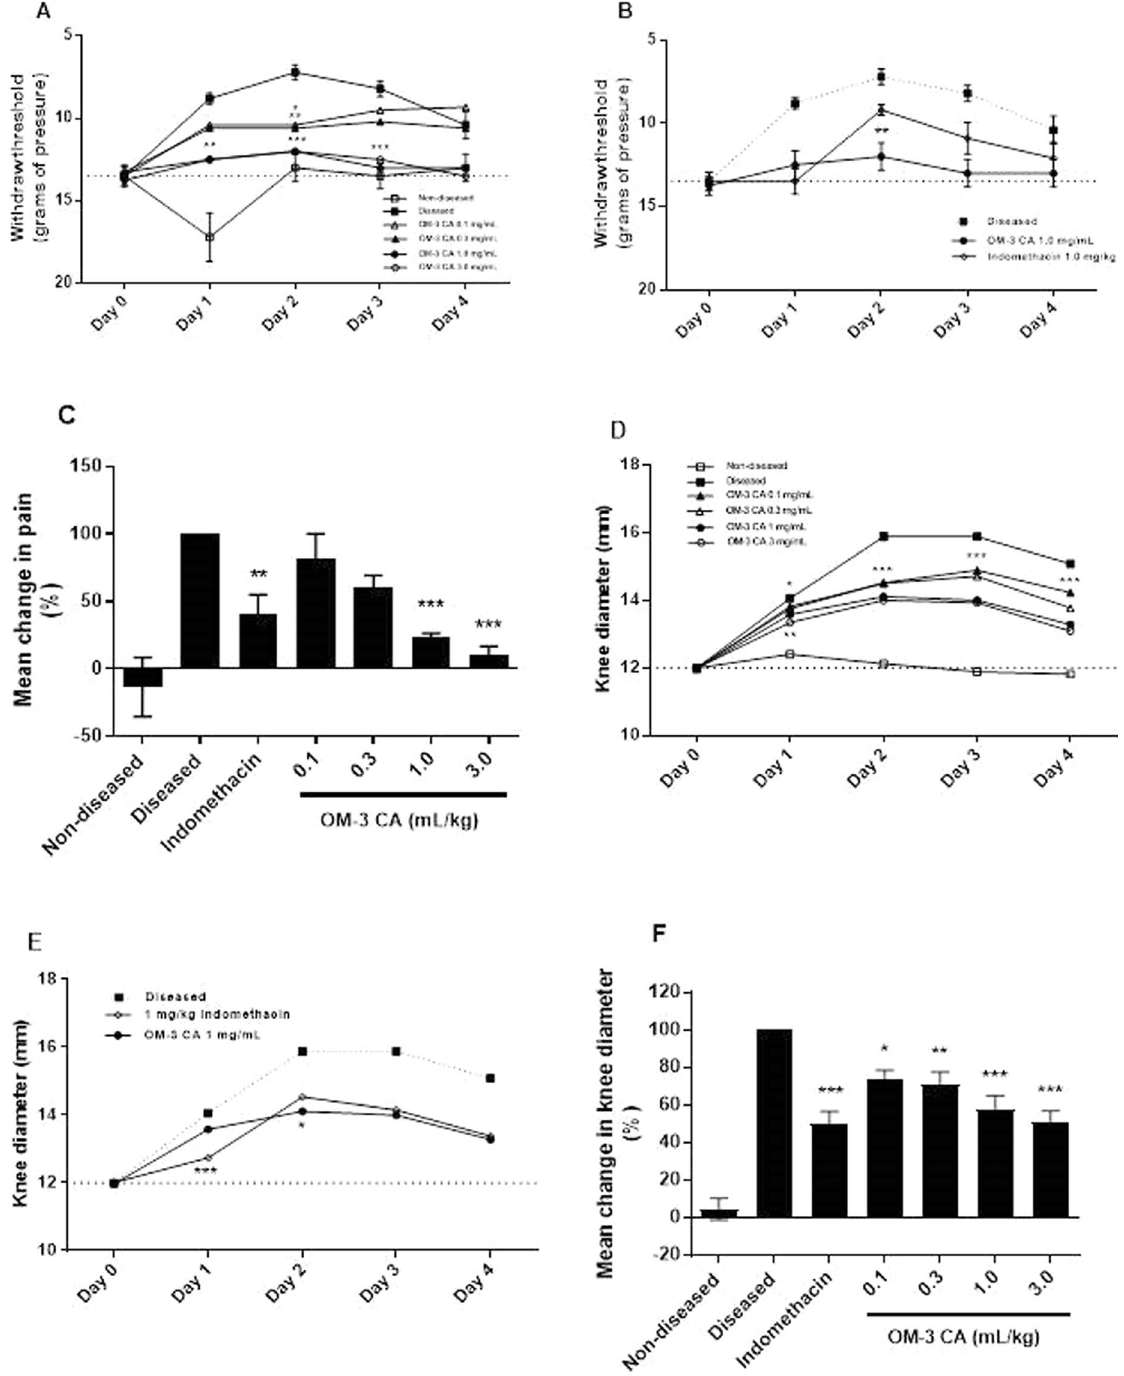
Figure 4. OM-3 CA efficacy in the rat intra-articular knee injection model. ( A ) Daily disease progression as measured by mean withdraw threshold (grams of pressure) over the 4-day study period for OM-3 CA treatment groups. ( B ) Daily disease progression as measured by mean withdraw threshold (grams of pressure) over the 4-day study period for OM-3 CA 1.0 mL/kg versus indomethacin 1.0 mg/kg daily. ( C ) Mean percentage change in pain level over the 4-day study period compared with the diseased group. ( D ) Daily disease progression as measured by knee diameter over the 4-day study period for OM-3 CA treatment groups. ( E ) Daily disease progression as measured by knee diameter over the 4-day study period for OM-3 CA 1.0 mL/kg versus indomethacin 1.0 mg/ kg. ( F ) Mean percentage change in knee diameter over the 4-day study period compared with the diseased group. * P < 0.05, ** P < 0.01, *** P < 0.001 versus the diseased group using Dunnett’s multiple comparison tests ( A , C , D , and F ) or versus indomethacin using t -tests ( B and E ). OM-3 CA: omega-3-carboxylic